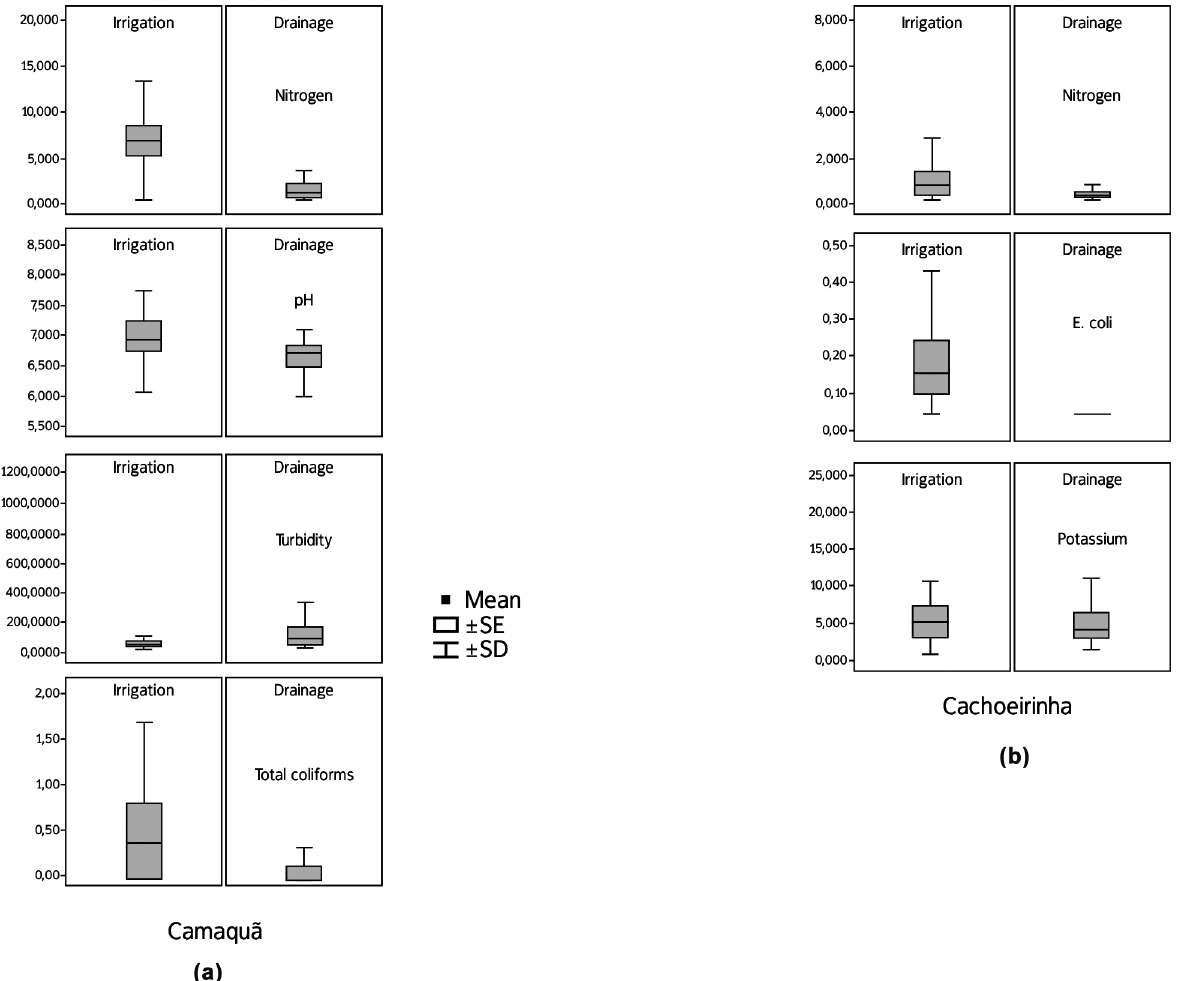
Figure 3 - Box-and-whisker plot representing the main discriminant variables between irrigation and drainage water quality. ( a ) Camaquã; ( b ) Cachoeirinha/RS/Brazil.